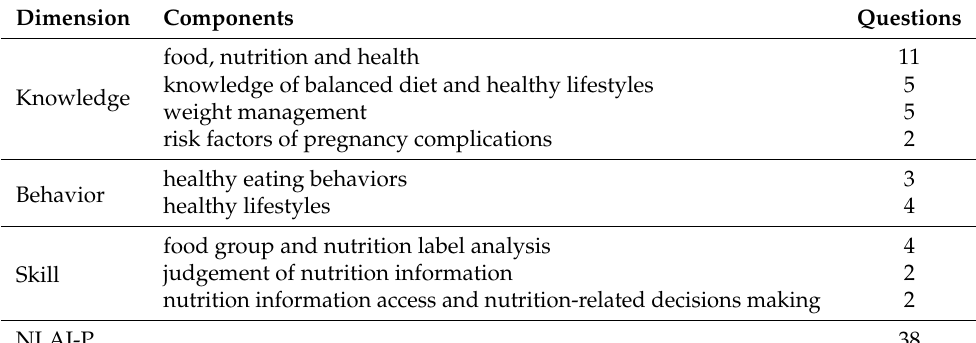
Table 2. The dimension and components of NLAI-P.